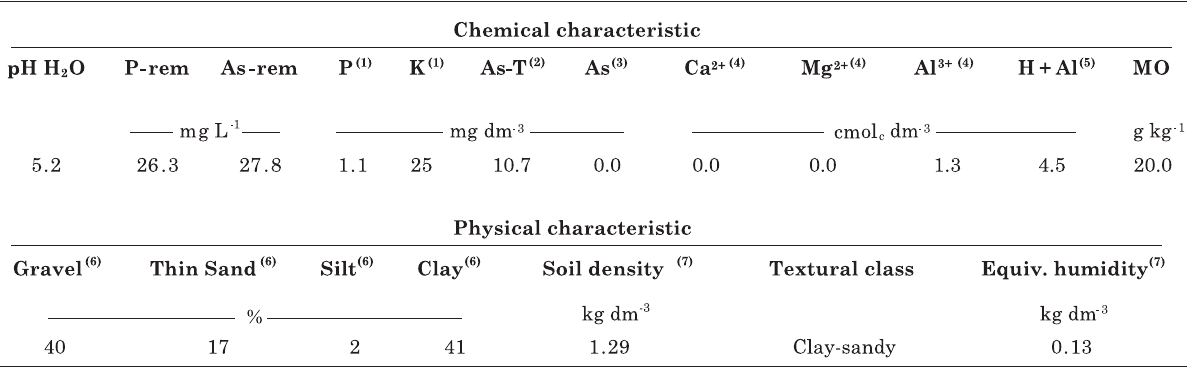
Table 1. Chemical and physical properties of soil samples used in the